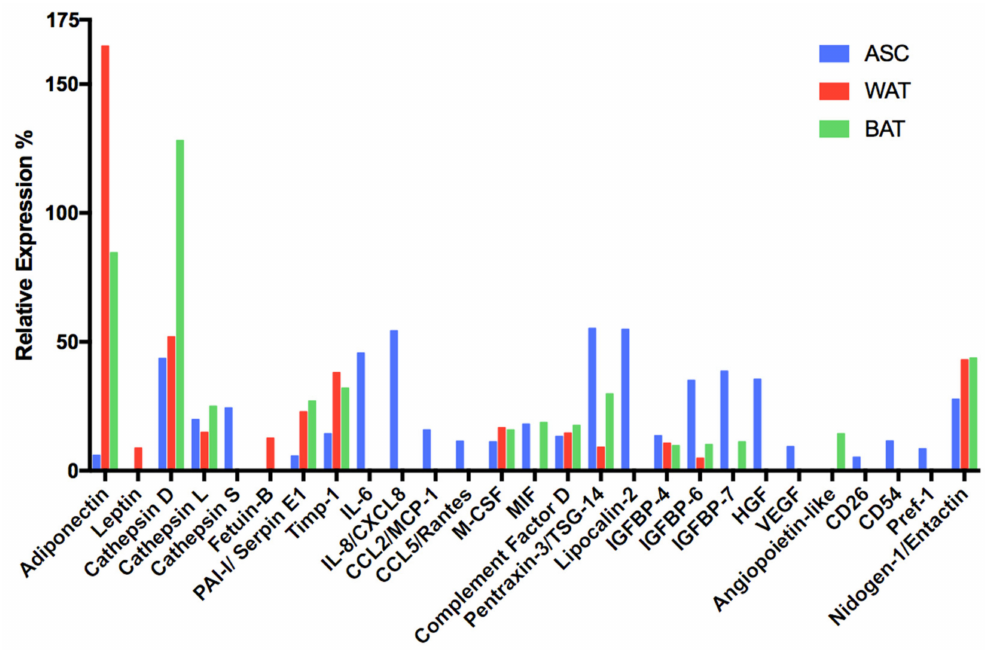
Figure 11. Proteome profiler of hASCs grown in UrSuppe medium (blue bar), US-WAT (red bar), or US-BAT (green bar) induction medium. Data are represented as mean pixel intensity (MPI) of fluorescence measured by the Licor acquisition system. Measured values were normalized on background fluorescence and on positive control to obtain a relative MPI. This experiment was performed with hASCs obtained from the biopsy of one donor. The following factors are not shown in the graph because of a very low expression in undifferentiated hASCS: Chemerin, Fibrinogen, IGFBP-2, LIF, PAPP-A, PCSK9, Aerpin A8